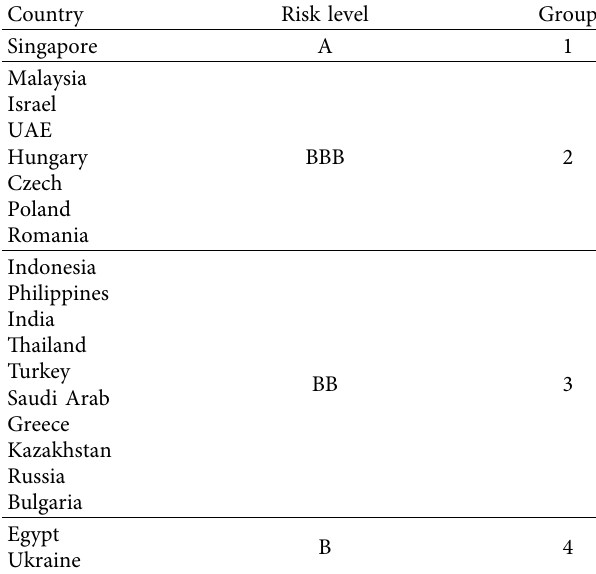
Table 2: Risk assessment of OFDI by technology-based enterprises in countries along the “Belt and